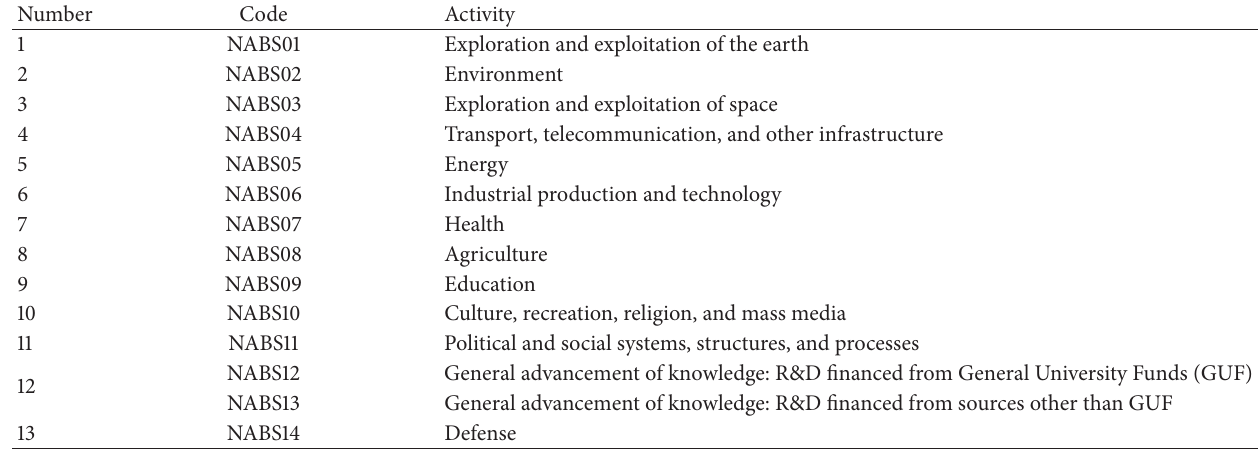
Table 1: Socioeconomic activities, NABS classification.